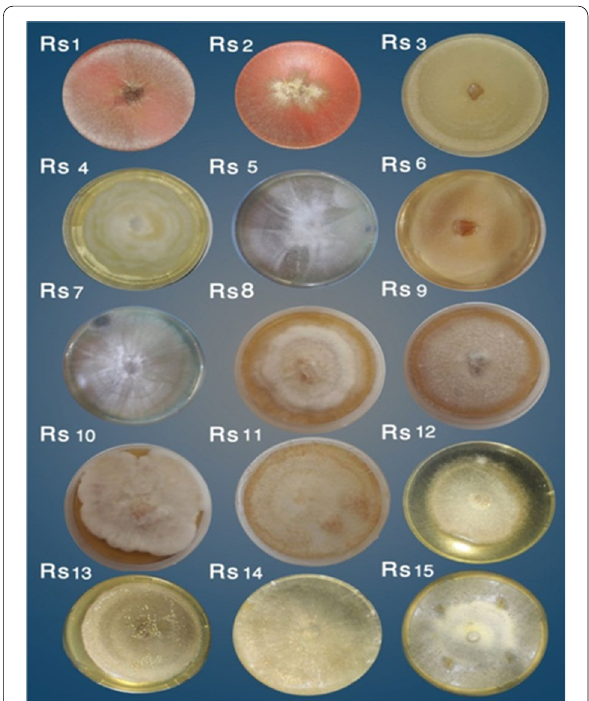
Fig. 6 Different culture of F. solani isolated from infected soil and wheat root samples